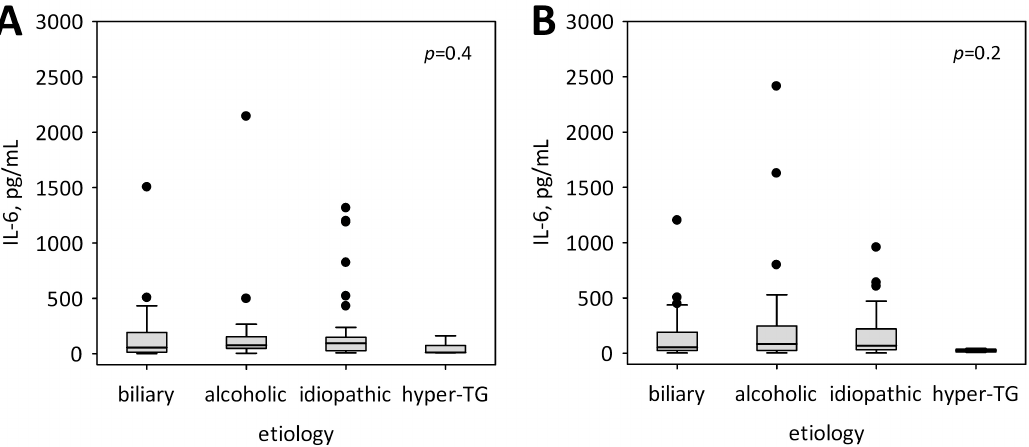
Figure 1. Serum concentrations of IL-6 among patients with various etiology of acute pancreatitis (AP) at admission ( A ) and on day 2 of hospital stay ( B ). Data are shown as median, interquartile range (box), non-outlier range (whiskers) and outliers (points).